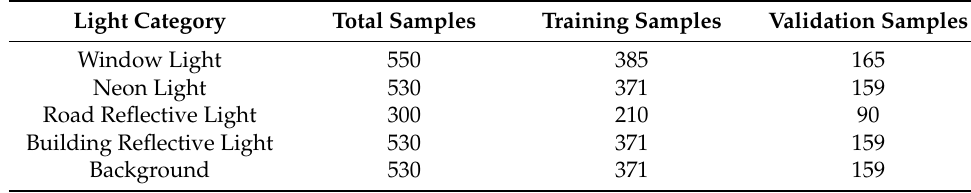
Table 3. Number of training and testing samples for different light